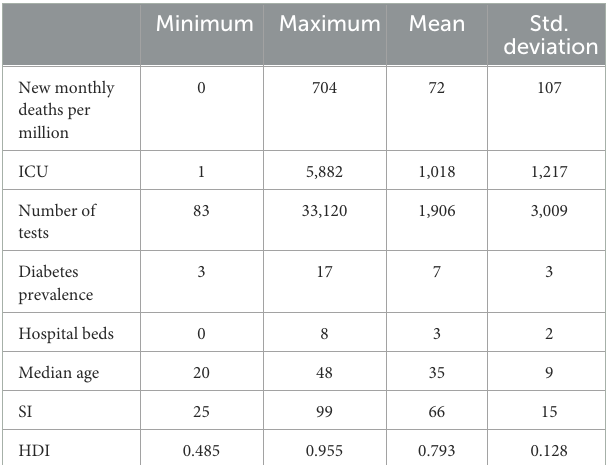
TABLE 3 Descriptive statistics of COVID-19